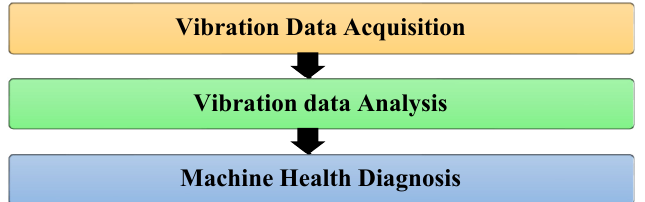
Figure 1. The overall system of vibration-based machine fault diagnosis.